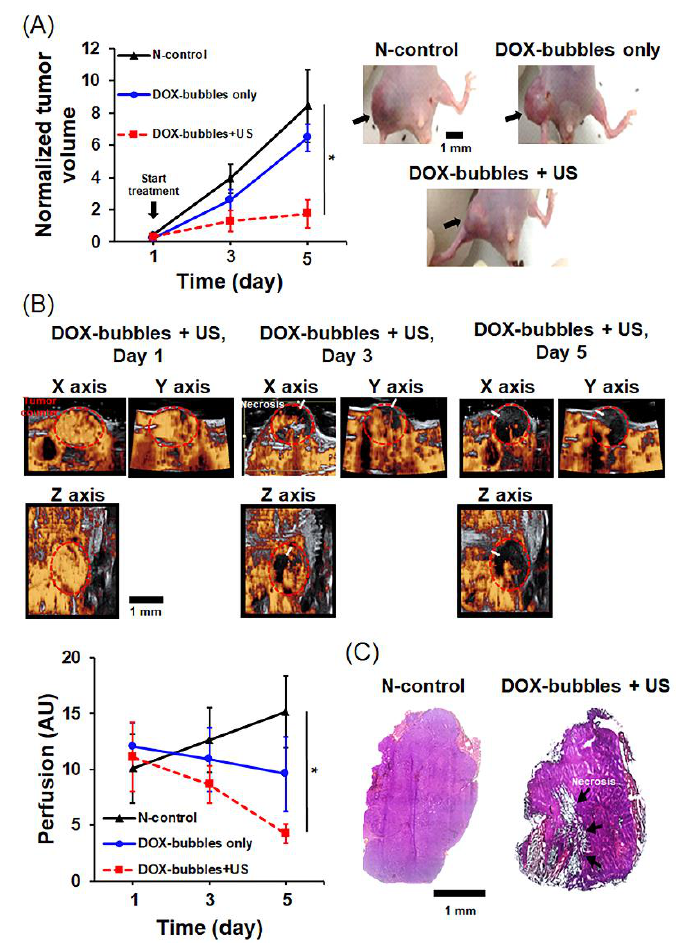
Figure 7. ( A ) Left: the therapeutic efficacy on the suppression of tumor volume; right: The macroscopic observation of the osteosarcoma tumor models of three groups. ( B ) The contrast-enhanced ultrasound imaging (CEUS) images (upper) and the tumor perfusion (bottom) before and after treatments with pure bubbles injection (the largest tumor section obtained from each scanning). White arrow: necrotic regions. Red dotted region: tumor contour. ( C ) Histological observation of the tumor after treatment. Black arrows: necrotic regions. Single asterisk, p < 0.05.